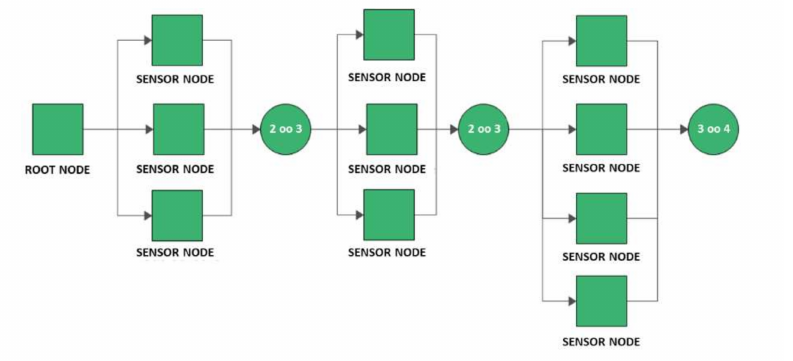
Figure 7. Reliability Block Diagram of the hybrid